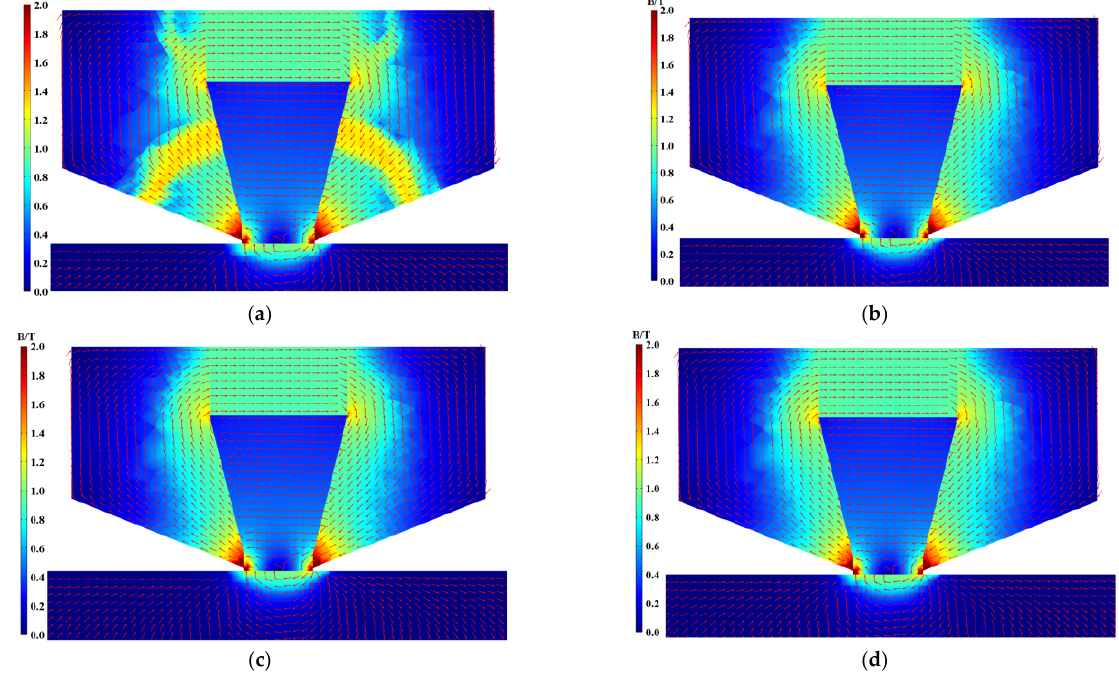
Figure 10. Magnetic-field cloud of the MR fluid seals at different speeds: ( a ) 300 rpm; ( b ) 600 rpm; ( c ) 900 rpm; and ( d ) 1500 rpm.